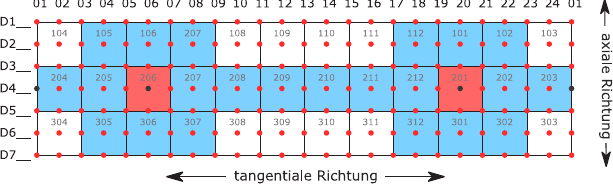
Fig. 3. Sketch of all detector position, which is also the first calculated arrangement. The results are given in Table I. The two segments highlighted in red are those in front of the HPGe-detectors. The blue segments are those within the measurement plane and above and below the red segments. Detector positions at the left and right side are the same.